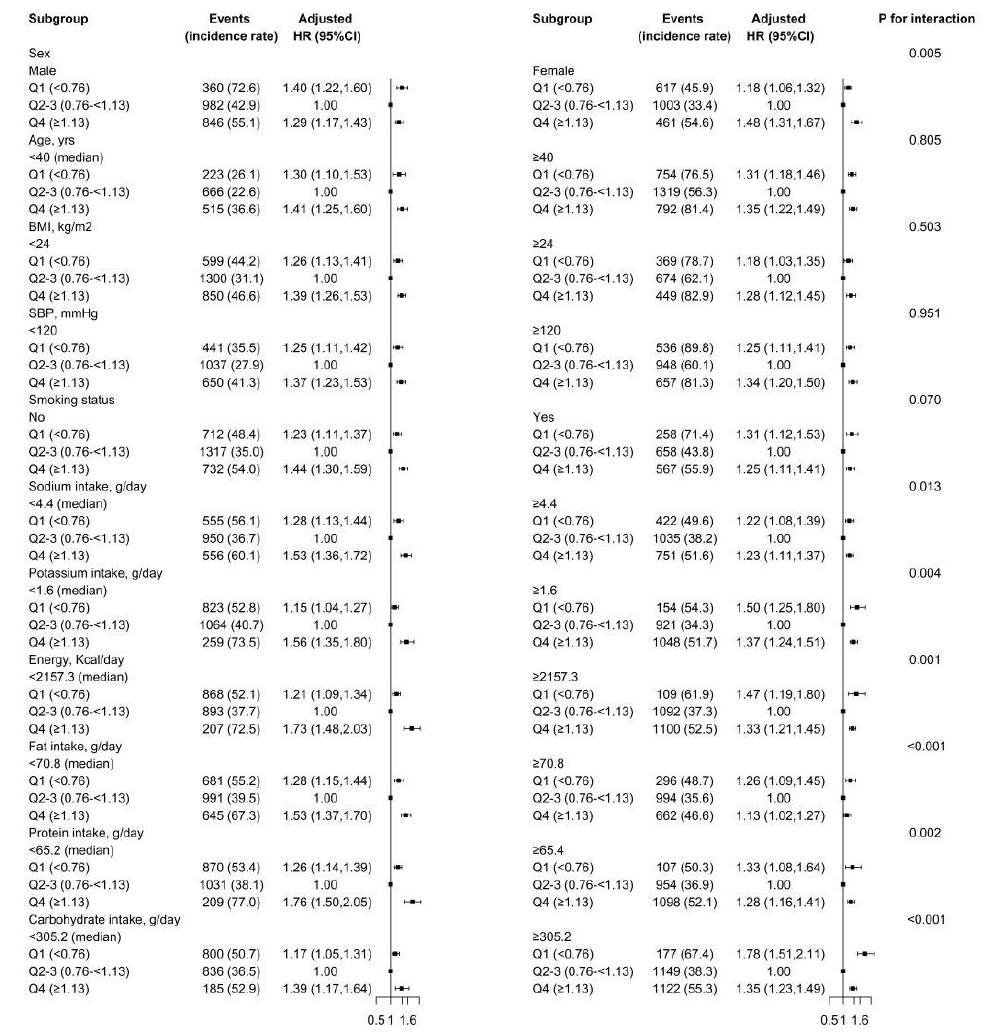
Figure 2. The relation of dietary thiamine intake (Q1 vs. Q2–3 vs. Q4) with risk of new-onset hypertension in various subgroups. Adjusted for sex, age, body mass index, survey year, regions, SBP, DBP, alcohol drinking, smoking, urban or rural residents, education levels, occupations, physical activity, intakes of energy, sodium and potassium, if not stratified.